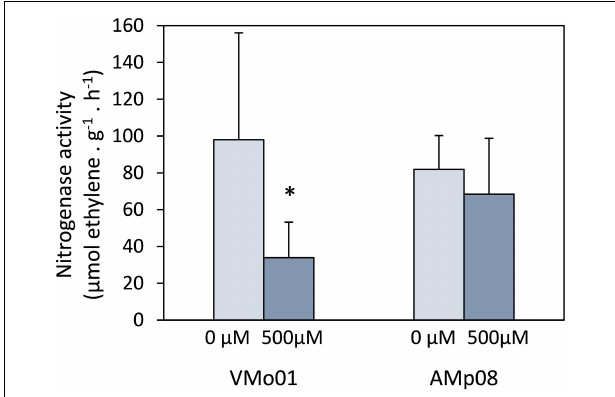
FIGURE 3 | Nitrogenase activity per gram of nodule in control and Hg-treated M. truncatula nodules inoculated with E. medicae strains VMo01 (sensitive) and AMp08 (tolerant). Five week-old plants were watered with nutrient solution containing 0 or 500 µ M HgCl 2 and harvested after 24 h. Three independent biological experiments were performed. In each experiment, 7–10 plants per treatment were analyzed. Mean values ± SD are represented. An asterisk indicates significant differences ( p < 0.05) between control and Hg-treated